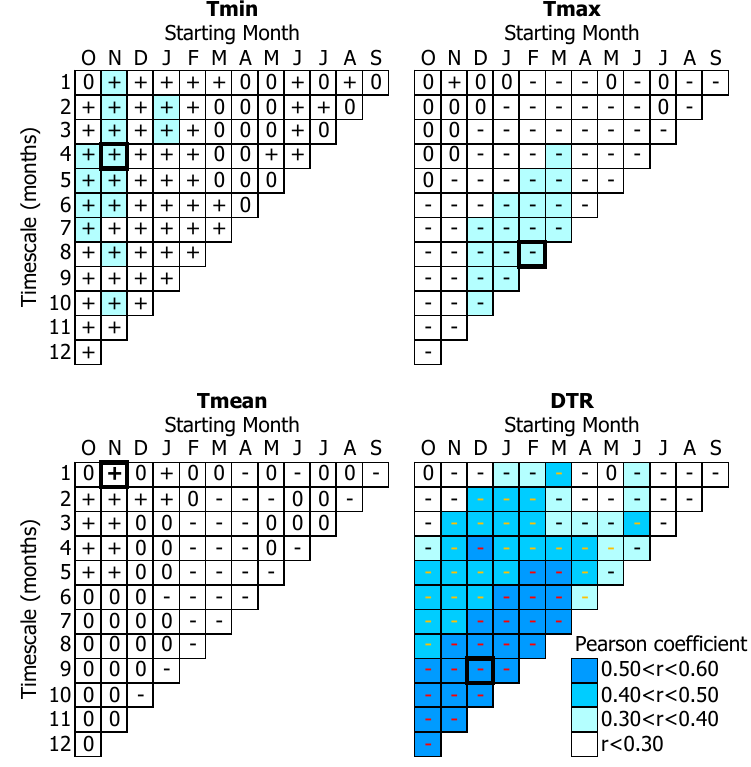
Figure 4. Pearson coefficients ( r ) derived from the correlation of annual TRWI with T min , T mean , T max and DTR at different timescales. The positive correlations are indicated with “+”, the negative with “-” and the negligible ( − 0.1 < r < 0.1) with “0”. The significance level is indicated with red ( p < 0.01), orange ( p < 0.05) or black (not significant) signs, while the strongest correlation (highest absolute r value) per parameter is marked with broader line.